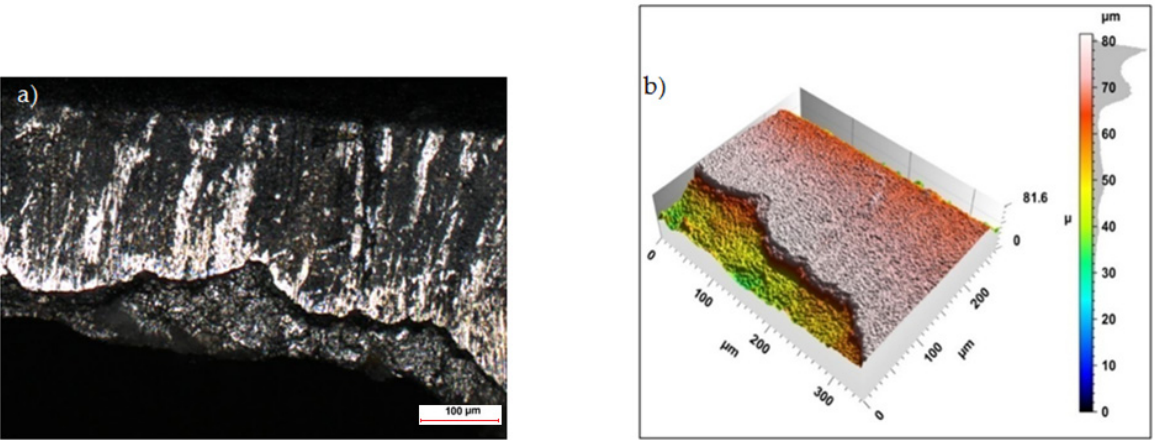
Figure 7. Views of the surface of the cut edge ( h c = 0.02 mm and v = 17.5 m/min): ( a ) surface photography, ( b ) surface topography (uncoated steel).